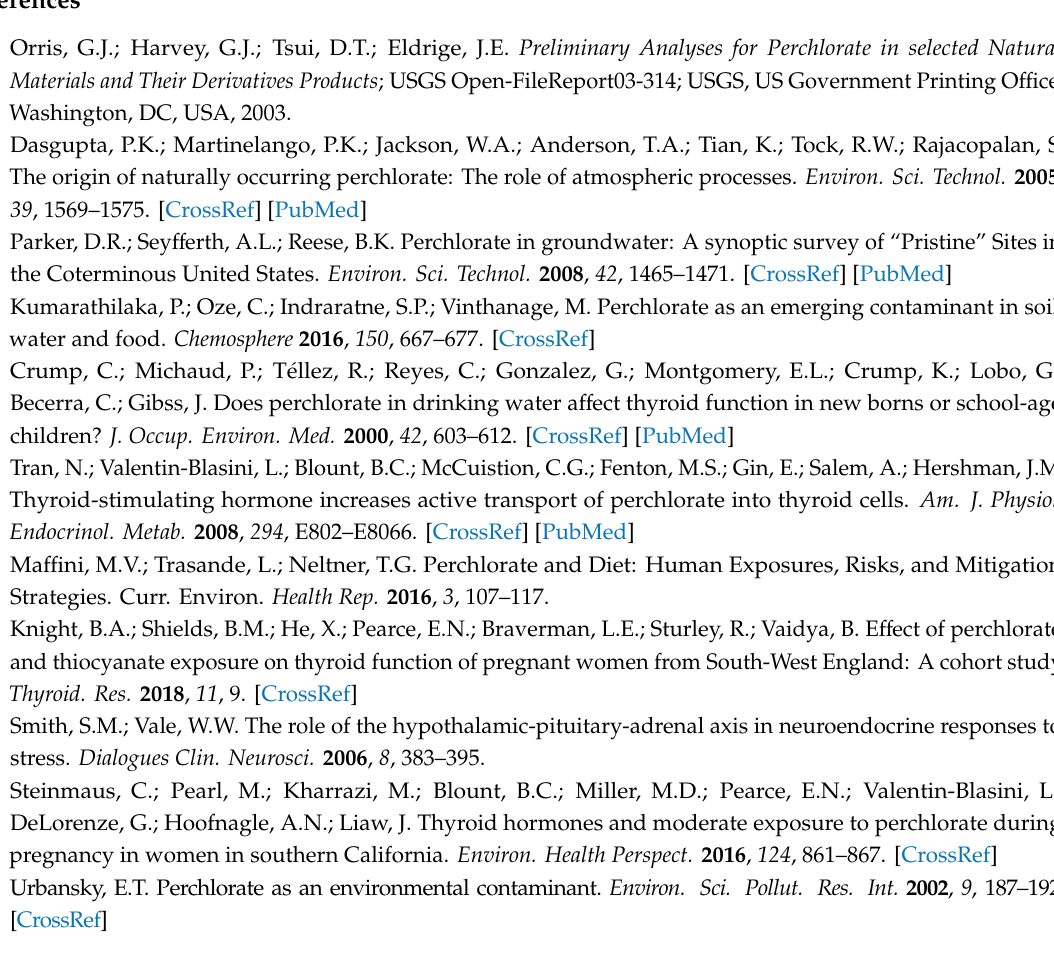
Table S1: List of Oligonucleotide primers used in this